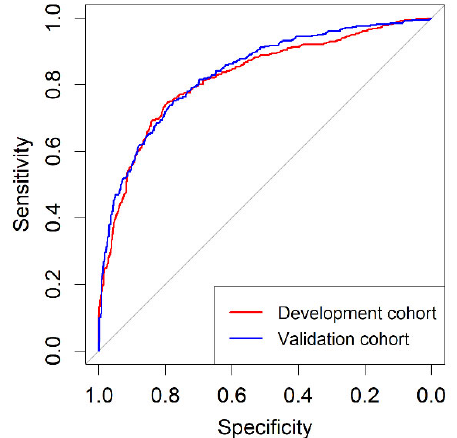
Figure 3. Discrimination ability represented by receiver operating characteristic curves of BCN ‐ RC 1 in the development cohort and validation cohort.